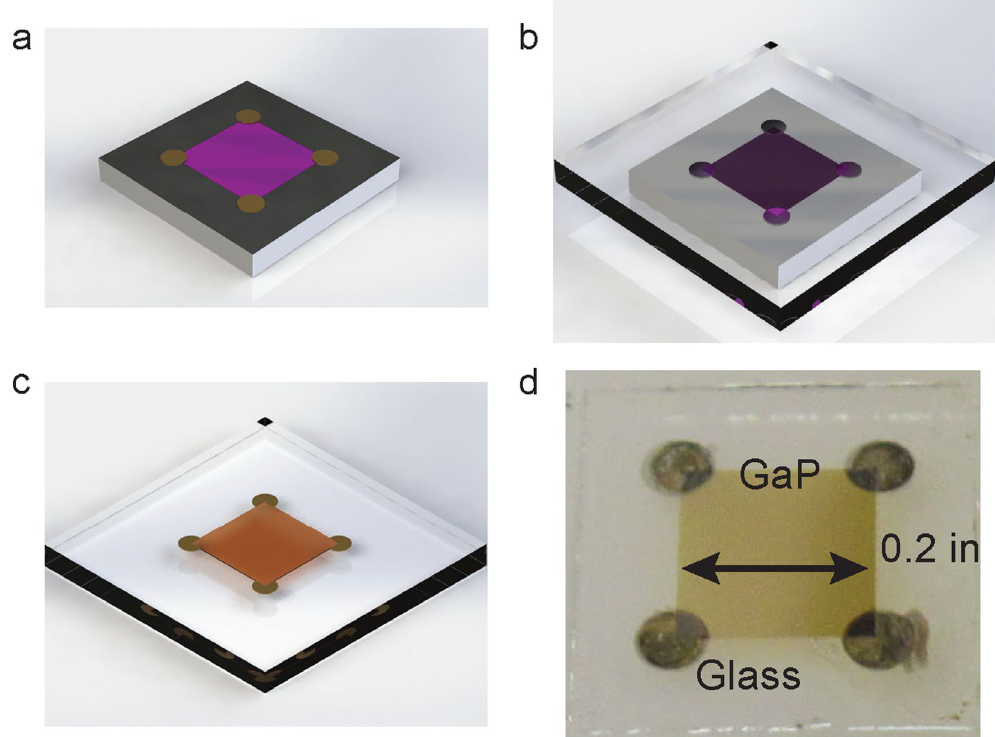
Figure 2. Schematic of the substrate removal process. ( a ) The GaP film is first etched to form a square 0.2 inches on a side. Metal contacts are then deposited and annealed on the corners, extending off the edge. ( b ) The sample is then bonded to a glass slide and ( c ) the silicon substrate etched away with XeF 2 , leaving the GaP film and metal contacts. ( d ) photograph of a typical contacted, substrate removed GaP